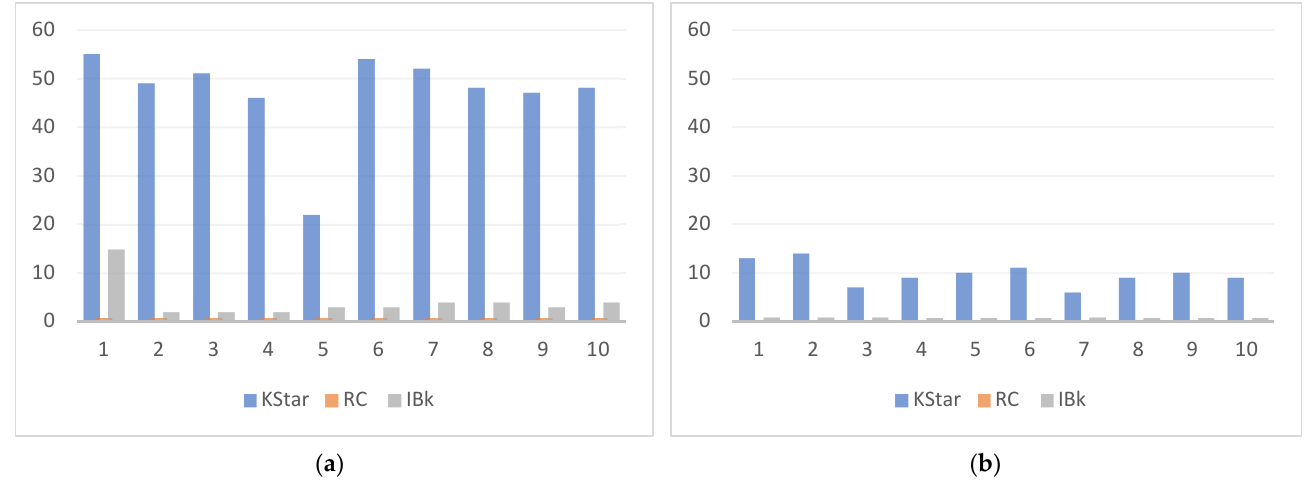
Figure 18. Classifiers’ Inference Elapsed Time in Milliseconds for ( a ) DS1 Test Samples and ( b ) DS2 Test Samples.